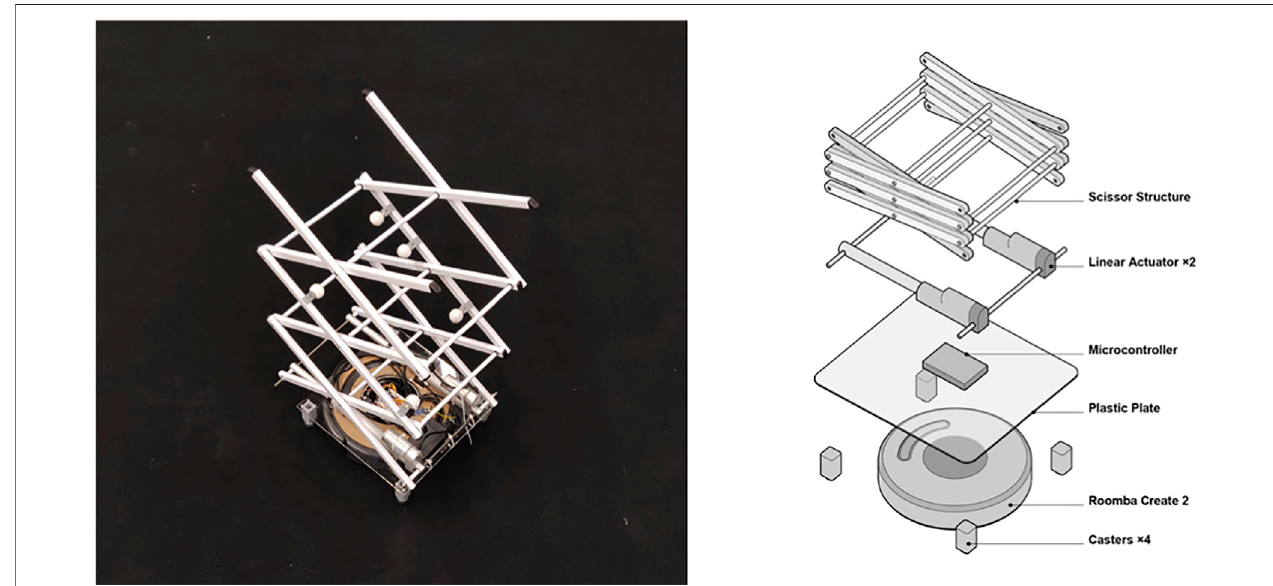
FIGURE 8 | The design of RoomShift, which integrates an expandable scissor structure with a Roomba robot.